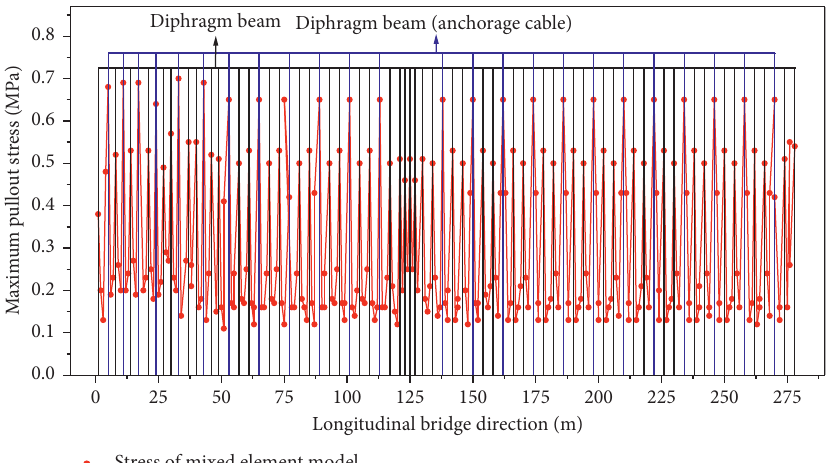
Figure 24: The maximum vertical tensile stress of the interface between the concrete deck and the steel boxes corresponding to each segment of the main girder at 17 o’clock.